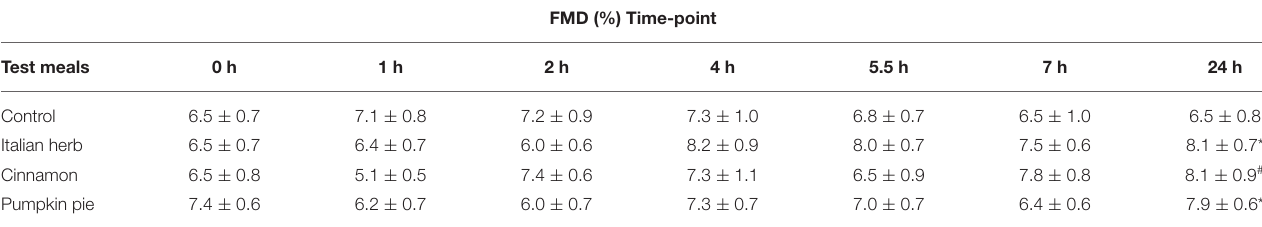
TABLE 3 | Flow-mediated dilation (FMD) over 24 h a .